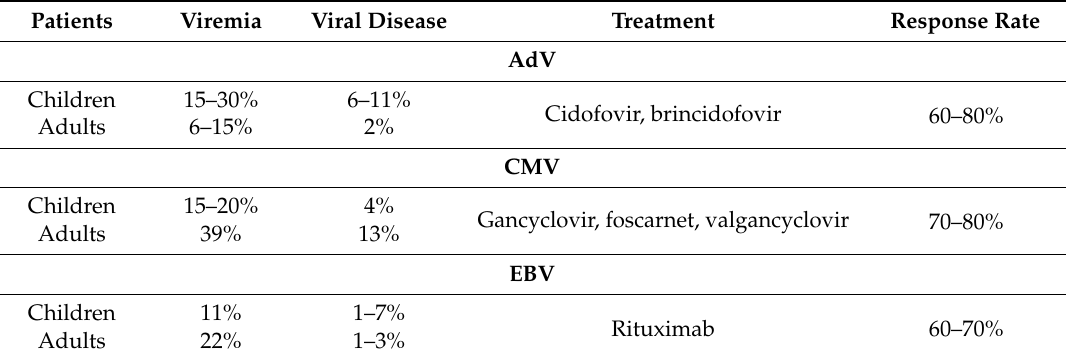
Table 1. Reported incidence of AdV, CMV and EBV post-transplant reactivation in peripheral blood, and disease-specific pharmacological treatment and rate of treatment response in children and adults undergoing haematopoietic stem cell